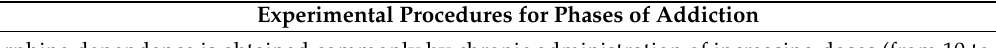
Table 2. The experimental procedures in particular phases of